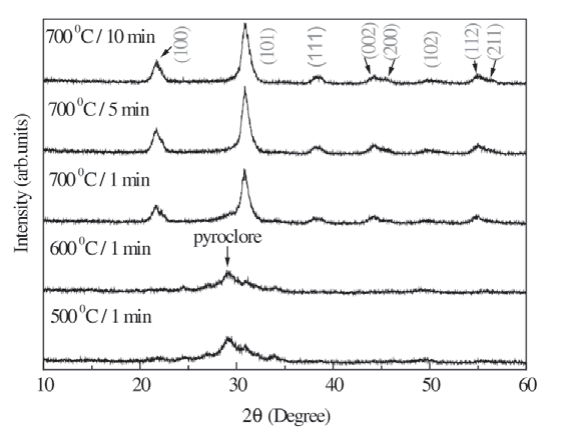
Figure 1. XRD pattern of the PZT films crystallized at different temperatures and